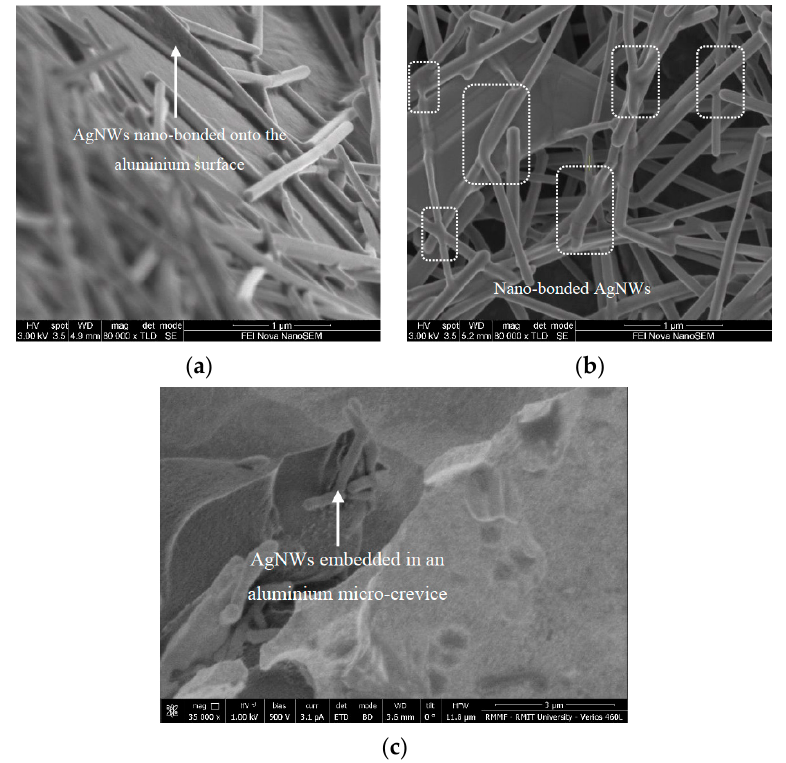
Figure 4. SEM images of AgNW-modified aluminium surfaces showing nanowires ( a ) bonded (metallic) to aluminium and ( b ) to each other and ( c ) embedded in aluminium micro-crevices. The effect of aluminium surface modification (i.e., AgNW concentration and/or deposition process) on the mode I crack growth resistance (R) curve at the metal–laminate interface is shown in Figure 5. The baseline FML composite (without AgNWs) yielded an R-curve exhibiting relatively low and unchanging fracture toughness with increasing crack length. In contrast, the R-curves for nano- reinforced FMLs revealed gradual increases in the fracture toughness within the initial crack growth phases (0–40 mm crack length) and reached steady-state fracture toughness values at crack length values above 40 mm. Figure 5. Representative growth resistance (R)-curves for FMLs obtained from mode I experiments. The critical initiation toughness ( (cid:1833) (cid:3010)(cid:3030),(cid:3036) ) and the steady-state (crack propagation) toughness ( (cid:1833) (cid:3010)(cid:3030),(cid:3046)(cid:3046) ) determined via mode I experiments for the baseline and AgNW-modified composites is given in Table 2. It should be noted that in this study, (cid:1833) (cid:3010)(cid:3030),(cid:3046)(cid:3046) was calculated by averaging the measured fracture toughness values between the crack length values of 40 and 80 mm. For the single-stage deposition, the strain energy release rate for crack initiation increased with increasing AgNW concentration. Compared to the baseline composite, the FML composites incorporating 1 and 3 g/m 2 of AgNWs revealed 86% (from 0.14 to 0.26 kJ/m 2 ) and 157% (from 0.14 to 0.36 kJ/m 2 ) improvements in the initiation toughness. The change in the deposition process from single to two stages did not alter the initiation fracture toughness with the measured (cid:1833) (cid:3010)(cid:3030),(cid:3036) value for 3g-2s (0.28 ± 0.12 kJ/m 2 ) comparable to that of the 3g-1s composite (0.36 ± 0.14 kJ/m 2 ). Table 2. Initiation and steady-state fracture toughness values determined via mode I experiments. 0